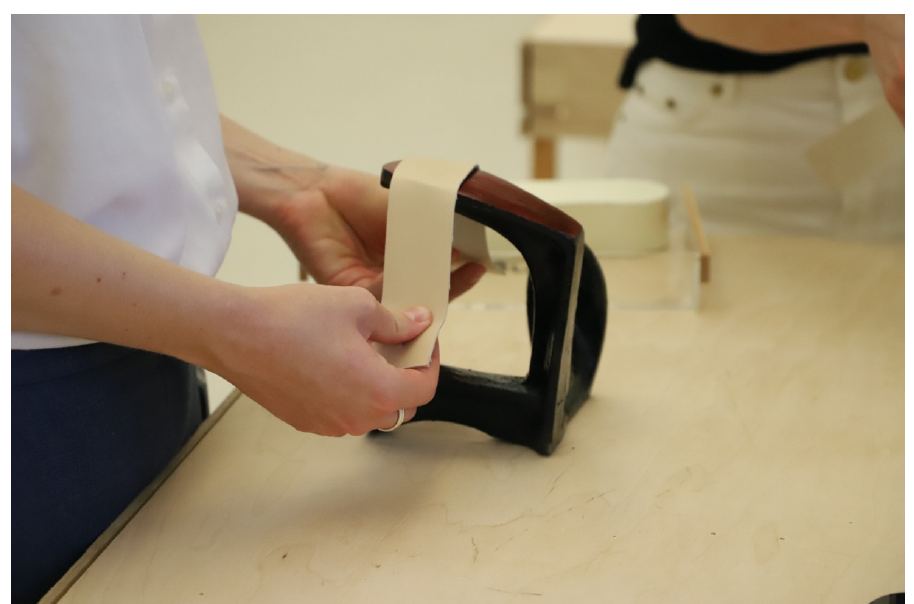
Figure 7. Materials Gym.